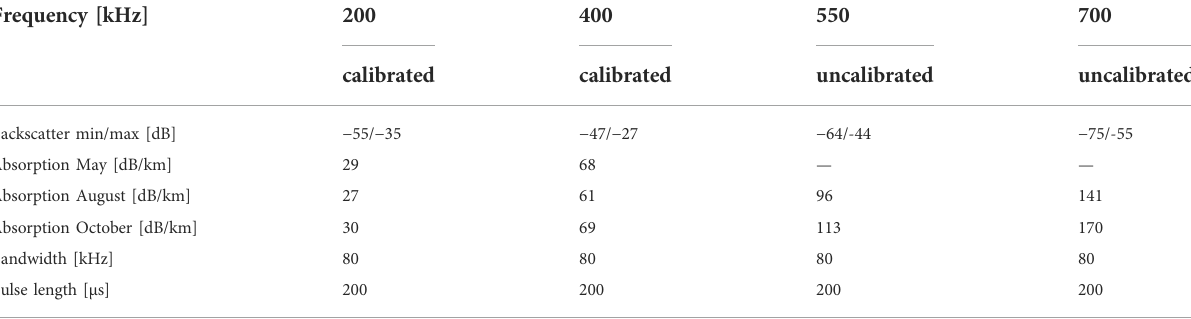
TABLE 1 Minimum and maximum backscatter intensities used in the Hohe Düne investigation area mosaics, and the absorption values used for the different